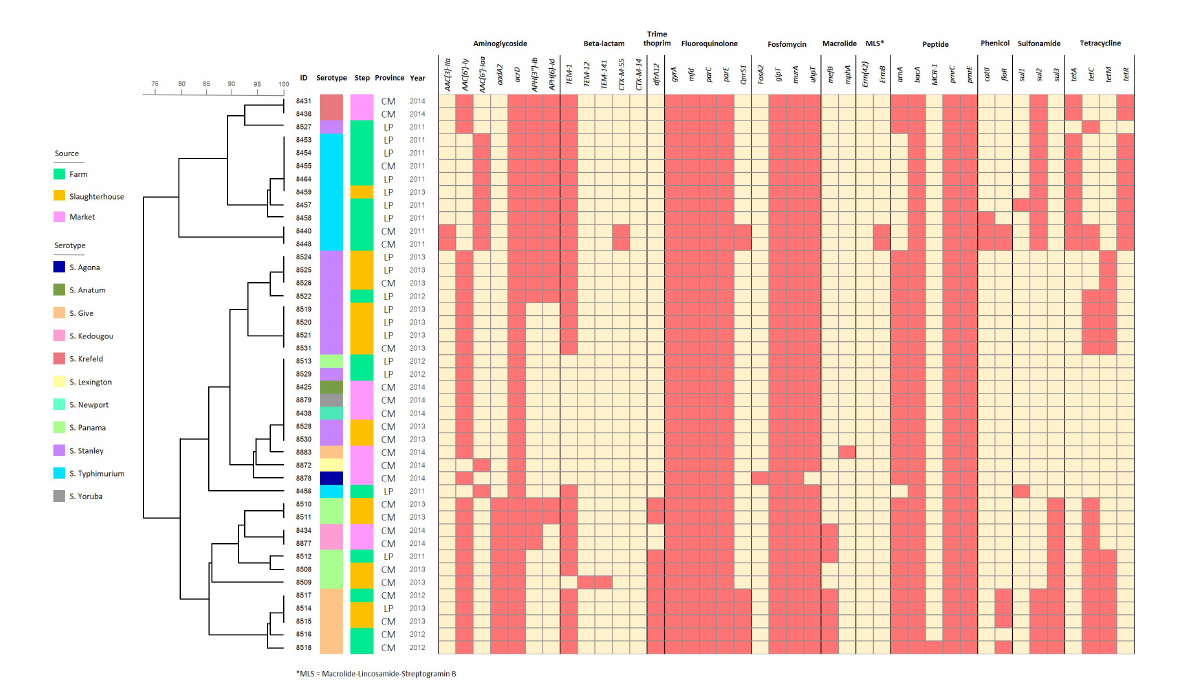
FIGURE4 Binary heatmap analysis of antimicrobial resistance genes harbored in the Salmonella isolates recovered from pork production chain circulating in Chiang Mai and Lamphun municipality area during the period